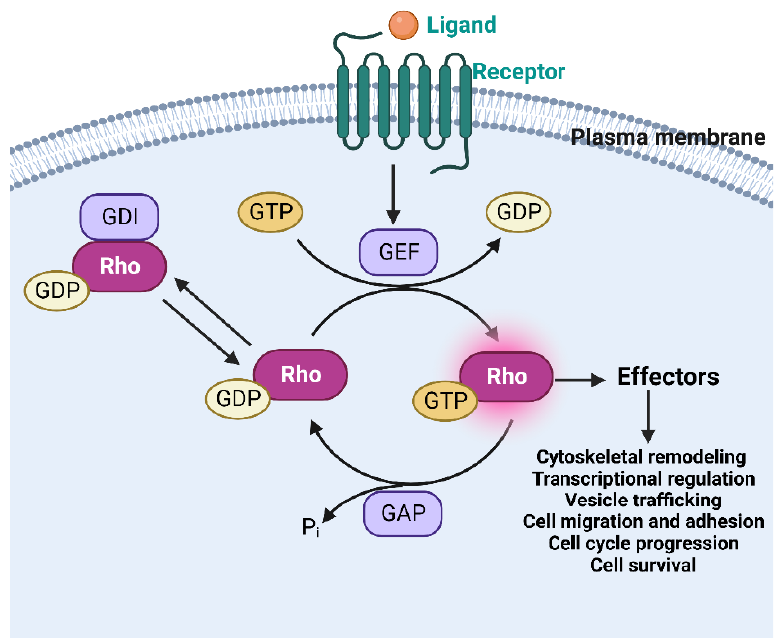
Figure 1. The Rho GTPase signaling cycle. Rho GTPases typically cycle between the active GTP- bound active form and the GDP-bound inactive form. This GTP-binding/GTP-hydrolysis cycle is primarily regulated by three classes of proteins: GEFs, GAPs, and GDIs. GEFs catalyze the exchange of GDP to GTP, activating the Rho GTPase, while the GAPs inactivate the RhoGTPase by hydrolyzing the GTP. The GDIs sequester and extract the Rho GTPases from the membrane to prevent the interactions between Rho and GEFs, GAPs, and downstream effectors. The activated Rho GTPase turns on effectors to transduce signals leading to platelet cell functional changes.